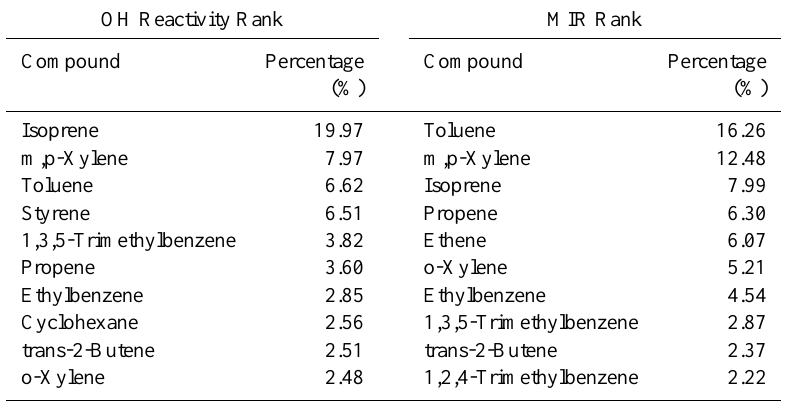
Table 5. Relative contributions to ozone formation by the top 10 VOCs species based on the Propy-Equiv and the MIR scales from June 2011 to May 2012 at GPACS. OH Reactivity Rank MIR Rank Compound Percentage Compound Percentage (%) (%) Isoprene 19.97 Toluene 16.26 m,p-Xylene 7.97 m,p-Xylene 12.48 Toluene 6.62 Isoprene 7.99 Styrene 6.51 1,3,5-Trimethylbenzene Propene Ethylbenzene Cyclohexane trans-2-Butene